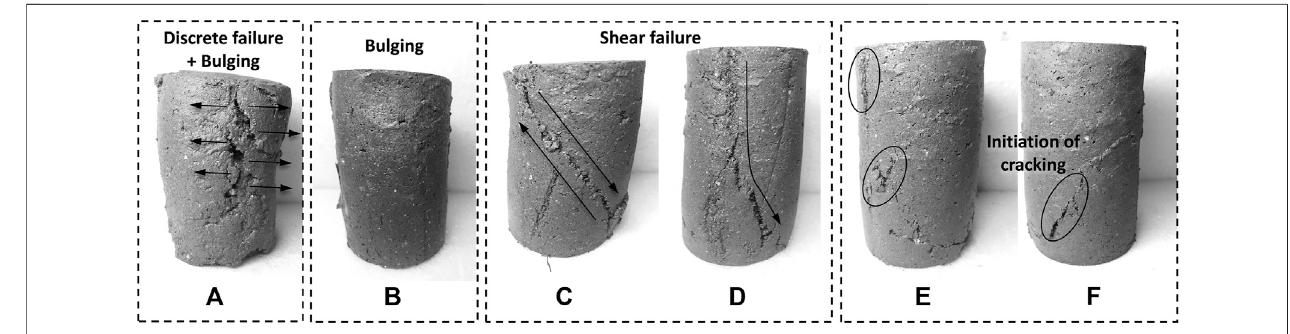
FIGURE 7 | Photos showing failure patterns of tested peat specimens: (A) untreated (case 1.1), (B) treated by MICP alone (case 2), (C, D) treated by 30 and 50% SSP alone (case 10 and 12, respectively), and (E, F) treated by MICP +30% SSP and MICP +50% SSP (cases 5 and 7, respectively).